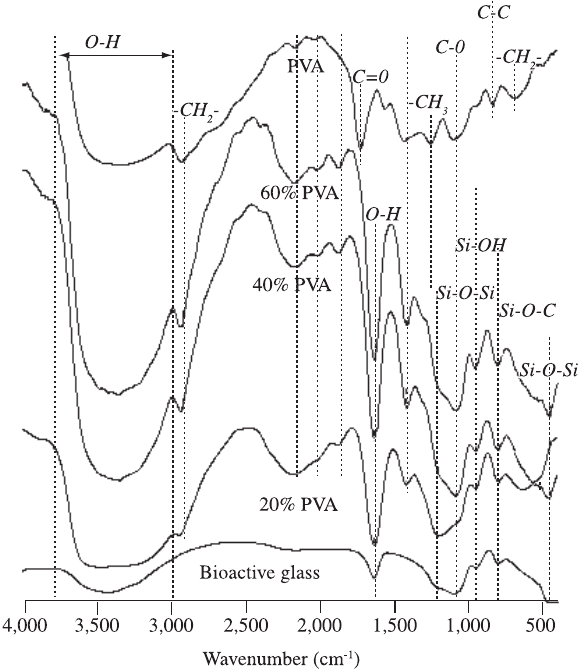
Figure 2. FTIR spectrum of bioactive glass, hybrid foams and